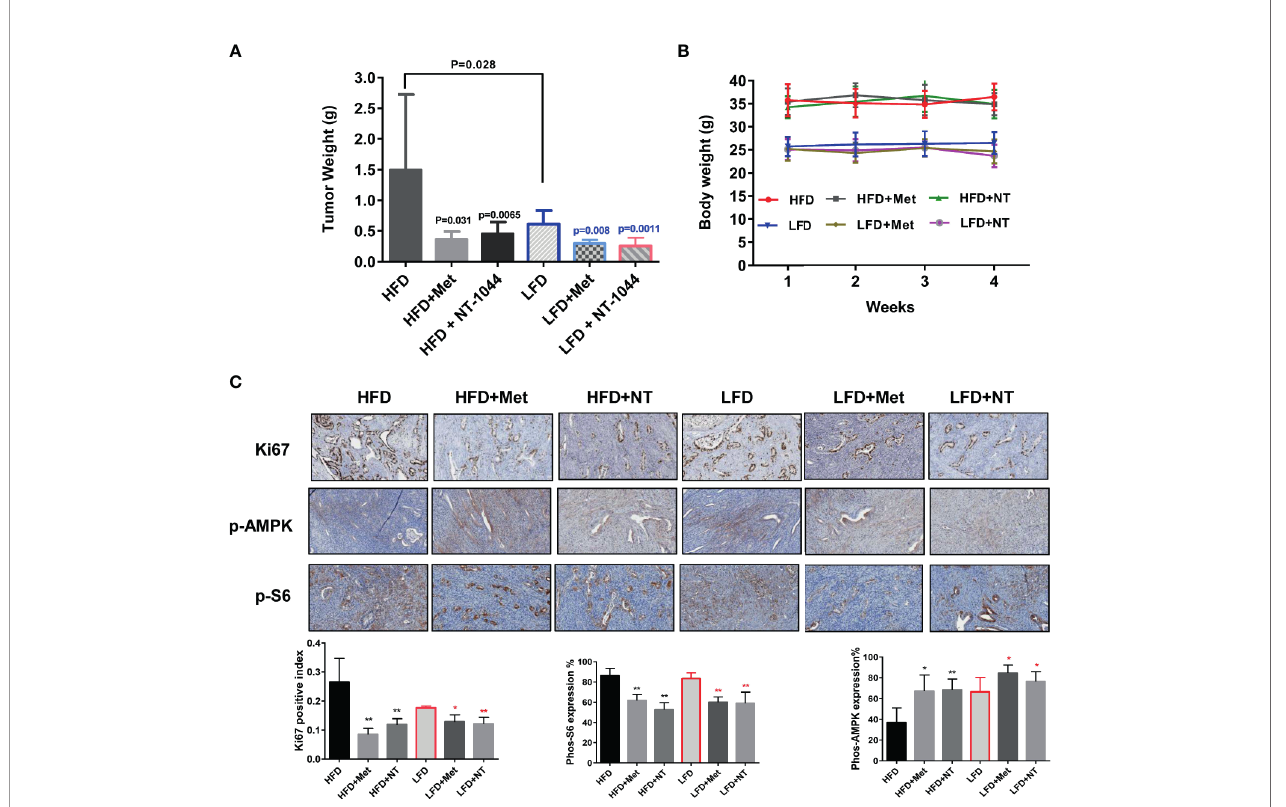
FIGURE 5 | NT-1044 inhibited endometrial tumor growth in both the obese and lean LKB1 fl / fl p53 fl / fl mice. LKB1 fl / fl p53 fl / fl mice were fed high fat diet (HFD) or low fat diet (LFD) at 3 weeks of age to induce obesity. The mice were divided into six groups: obese, obese + metformin, obese+NT-1044, Lean, lean + metformin. Lean +NT-1044. The obese and lean mice in both groups were treated with NT-1044 or metformin (200 mg/kg, oral gavage for NT1044 and drinking water for metformin) or placebo for 4 weeks. Obesity promoted tumor growth in obese mice versus lean mice. Either metformin or NT-1044 signi fi cantly reduced tumor weight in the obese and lean mice, with a greater impact on tumor weight in obese mice (A) . During treatment, there were no signi fi cant changes in body weight in the six groups (B) . Change in expression of Ki-67, phosphorylated-S6 and phosphorylated-AMPK were assessed by immunohistochemistry in the endometrial cancer tissues. The expression of Ki-67 and phosphorylated-S6 was reduced and phosphorylated-AMPK was increased in both groups after NT-1044 or metformin treatment (C) . *p < 0.05, **p <